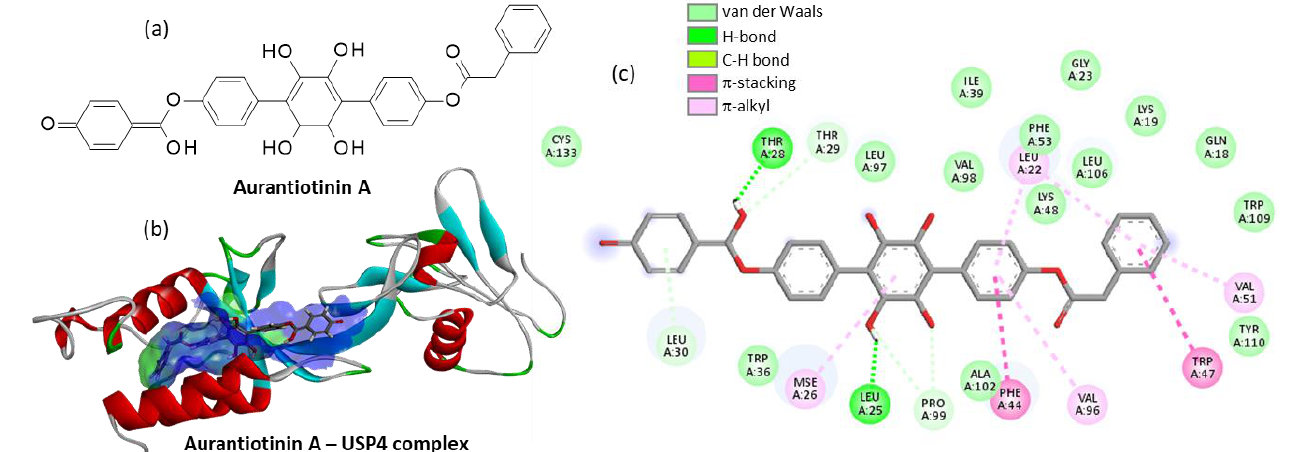
Figure 7. ( a ) Structure of aurantiotinin A. ( b ) Ribbon model of aurantiotinin A bound to the V98 site of USP4, with the solvent accessible surface (SAS) colored. ( c ) Binding map contact, with the indicated color code.